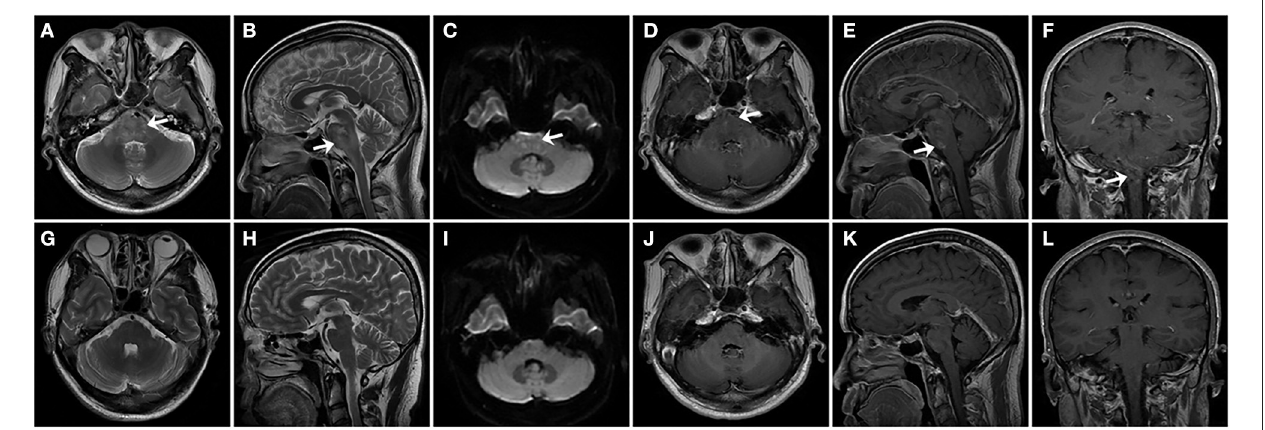
FIGURE 1 | In patient 1, series of brain MRI revealed small and scattered lesions distributed in the pons (indicated by arrows), presenting hyperintensity on horizontal and sagittal T2-weighted images (A,B) , high signal on the diffusion-weighted image (DWI) (C) , and slim contrast enhancement after Gd-DTPA injection on horizontal, sagittal, and coronal position (D–F) . After treatment for 6 months, follow-up MRI images were seen in the patient. Horizontal and sagittal T2-weighted images (G,H) , DWI (I) , Gd-DTPA enhancement on horizontal, sagittal, and coronal position (J–L) , showing complete regression of lesions in the pons.